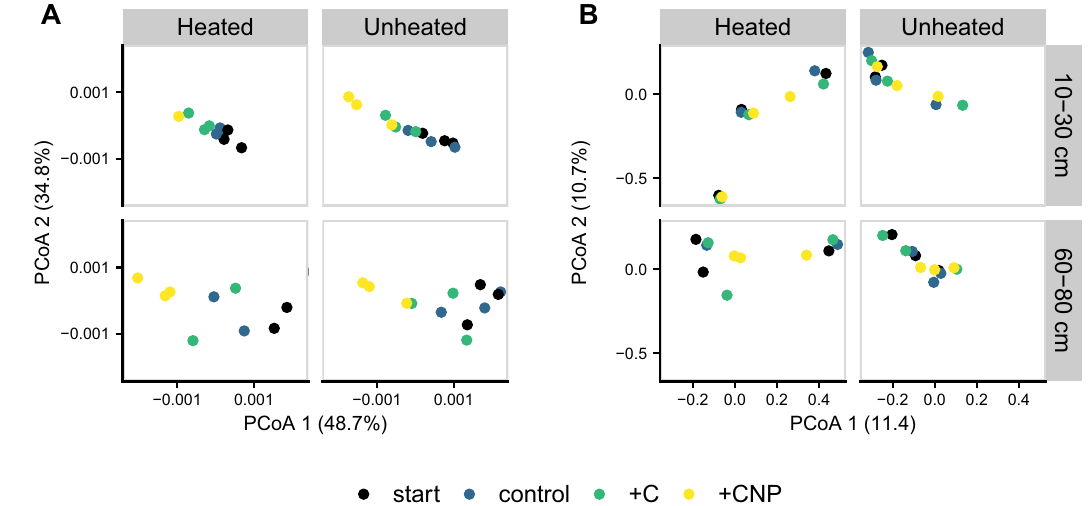
Fig. 4 Change in community composition during the 30-d incubation. Incubations were amended with carbon (C) or carbon, nitrogen, and phosphorus (CNP) compared to the starting conditions and unamended control for prokaryote ( A ) and fungi ( B ) across the heating treatments and depths. Points denote individual samples.